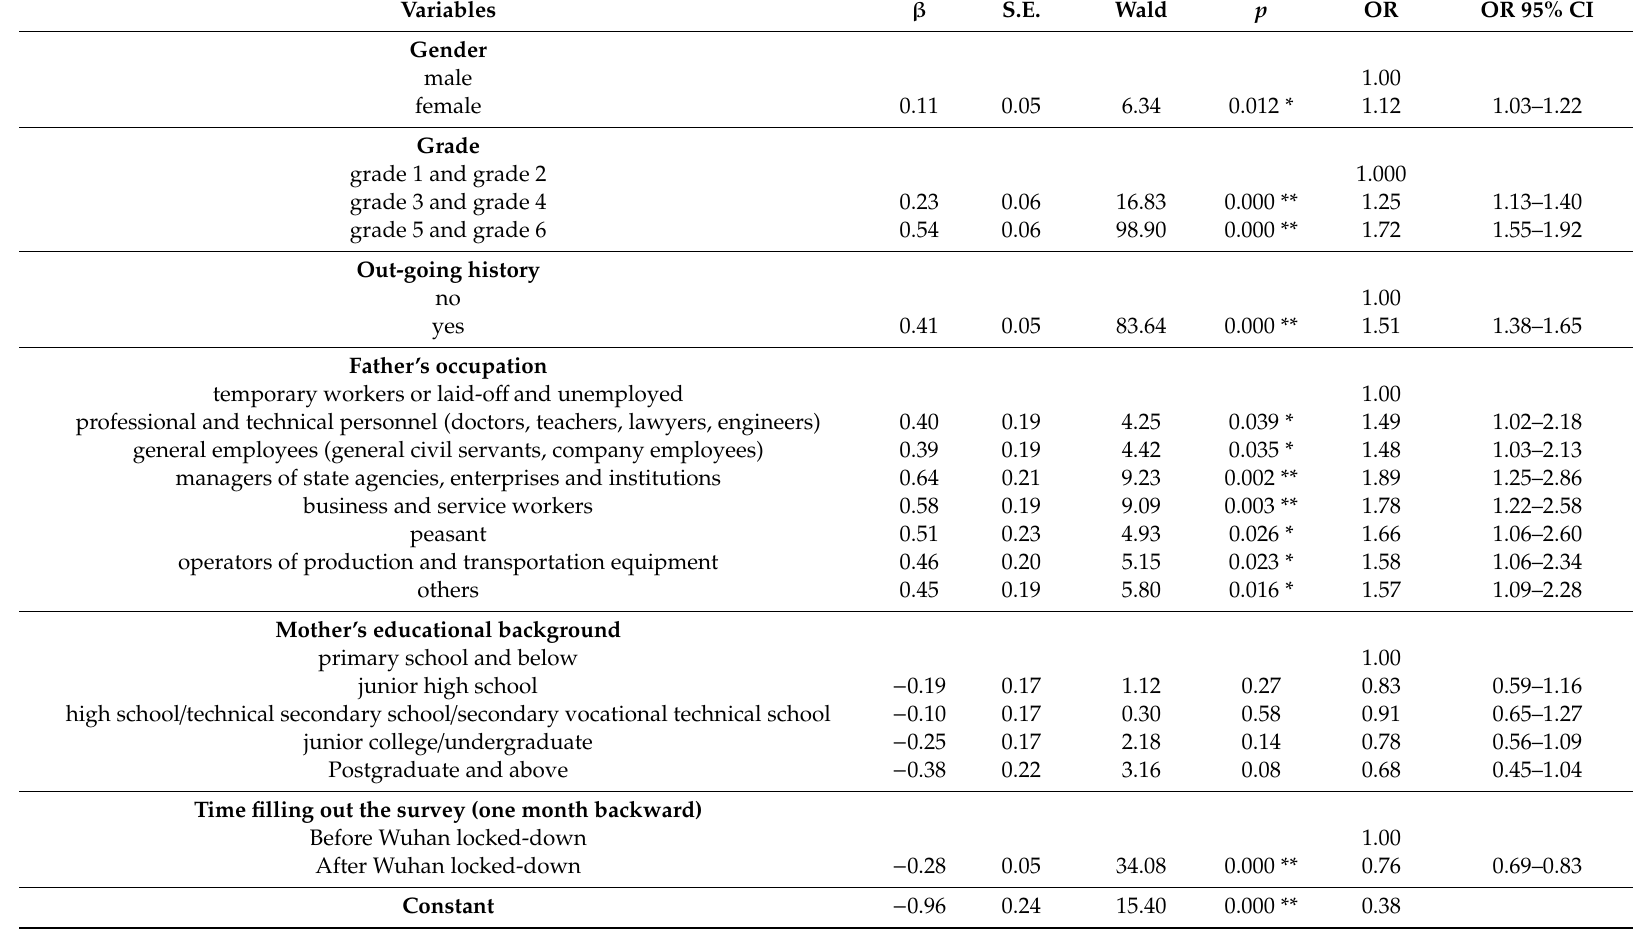
Table 2. Binary logistic regression analysis on the influencing factors of hand hygiene ( n = 8569). Variables